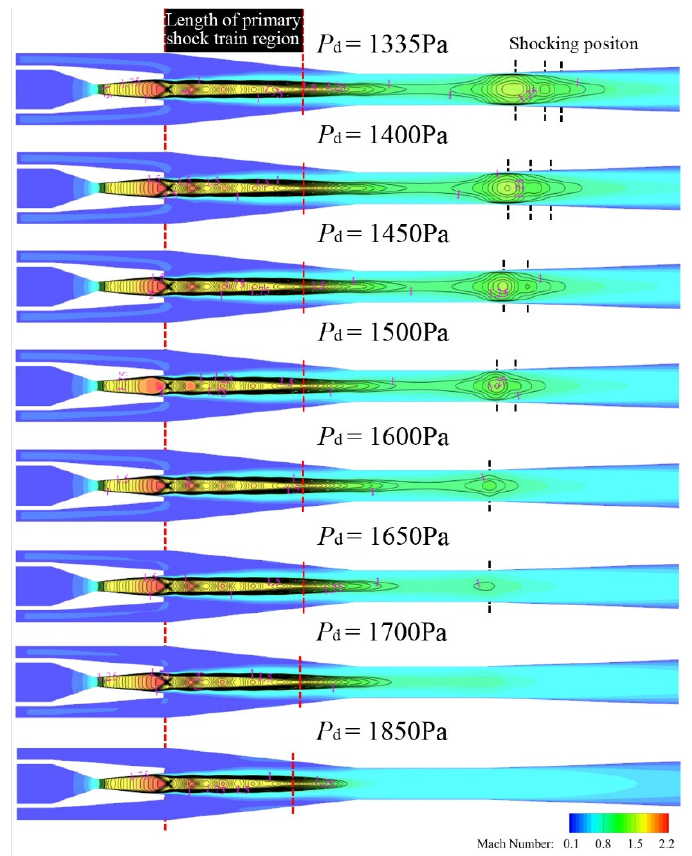
Figure 5. Ma counters with different P d .